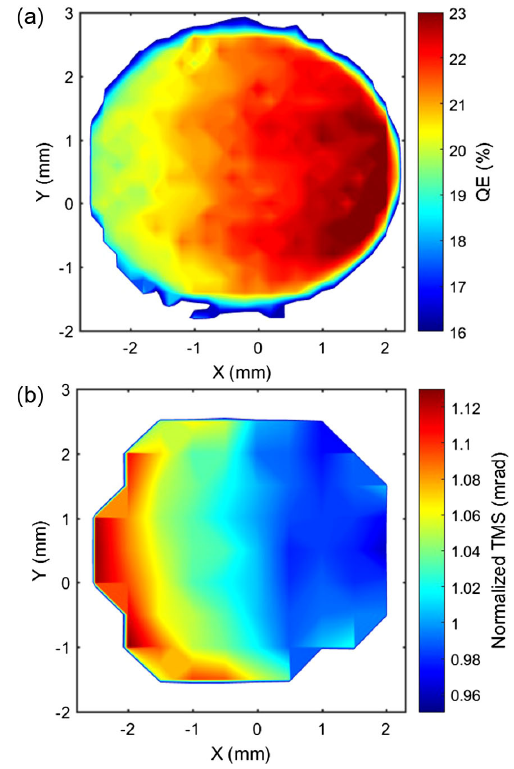
cathodes.FIG. 3. QE map (a) and TMS map (b) of the Cs 2 Te cathode #678.1. The QE map is measured with the laser diameter of 0.25 mm and the step size of 0.2 mm. The TMS map is measured with laser diameter of 0.5 mm and the step size of 0.5 mm.